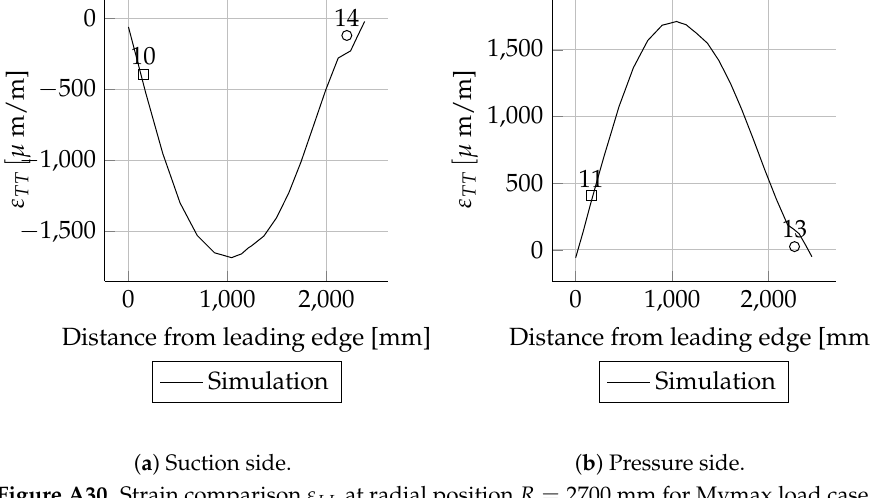
Figure A30. Strain comparison ε LL at radial position R = 2700 mm for Mymax load case.